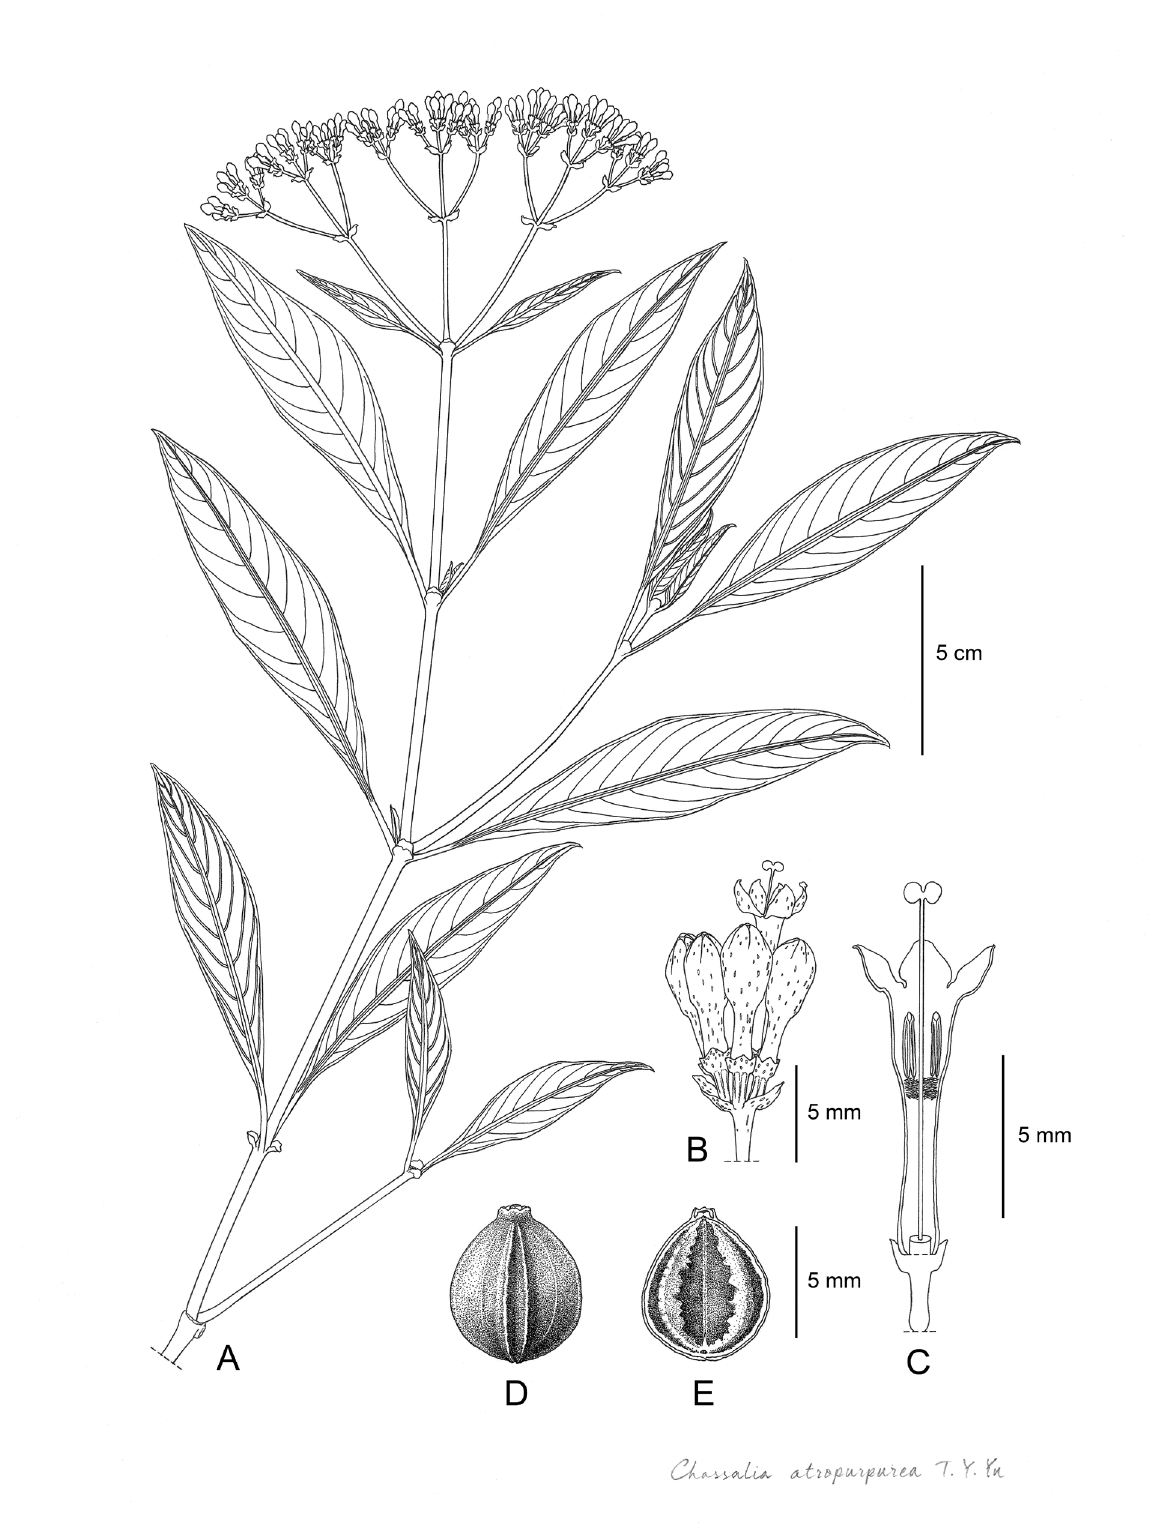
Fig. 4. Chassalia atropurpurea T.Y.Yu sp. nov. A . Flowering shoot. B . Capitulum. C . Longitudinal view of corolla. D . Dry fruit. E . Pyrene ventral surface. A–C from Paul Chai S 33830 ; D–E from Paul Chai S 36121 . Drawn by T.Y.